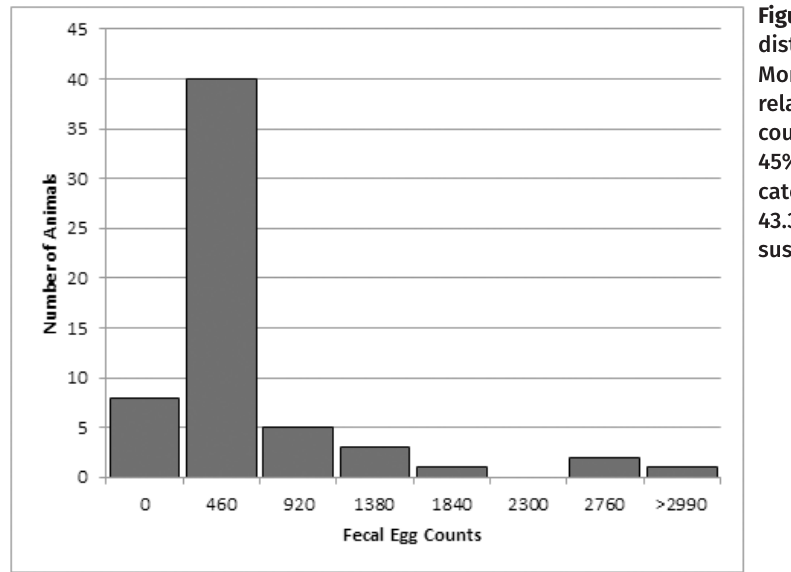
Figure 1. Frequency distribution of the 60 Morada Nova ewes in relation to fecal egg count (FEC). From this, 45% of the animals were categorized as resistant, 43.3% resilient and 11.7% susceptible (Figure